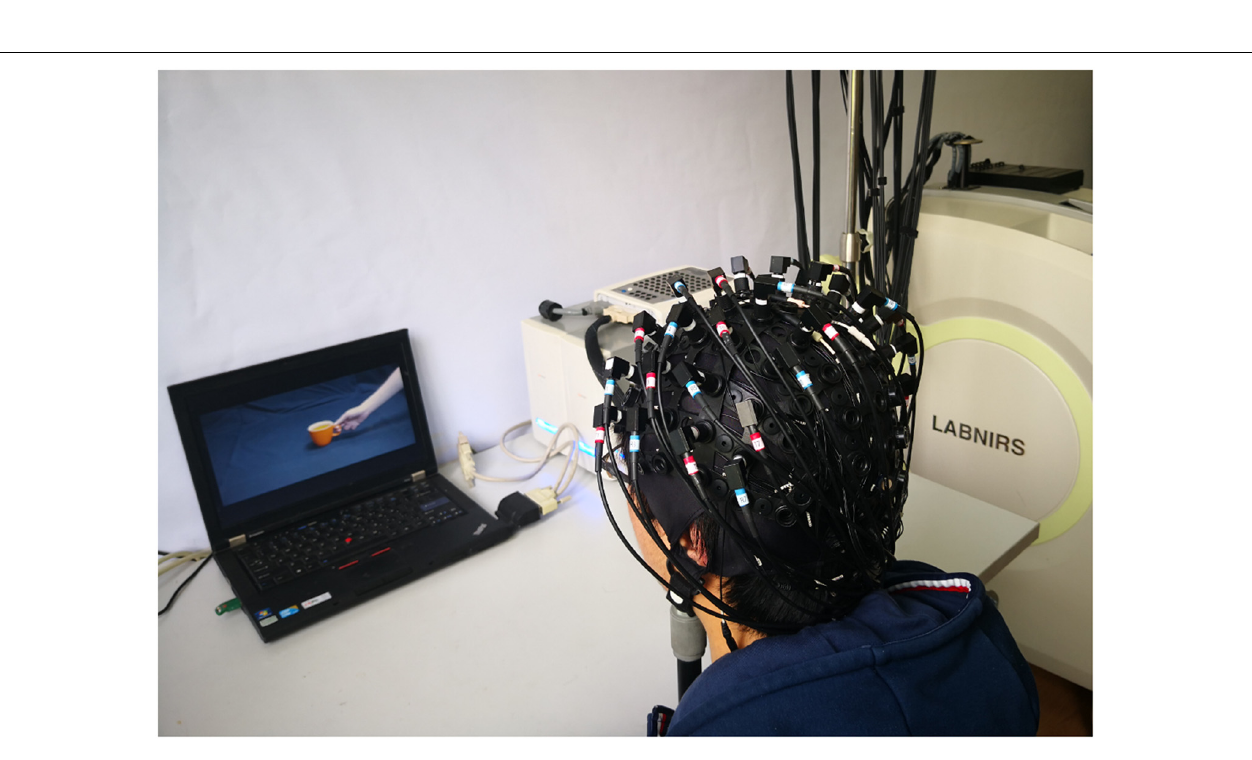
FIGURE 2 | Experimental